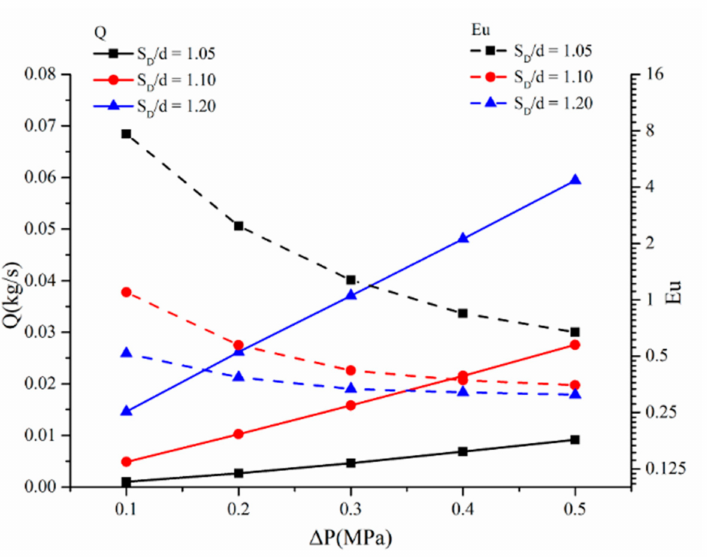
Figure 8. Euler number Eu and leakage rate Q with different gaps. The left axis of Q represents the leakage rate, shown in solid lines, and the right axis of Eu represents Euler number, shown in dotted